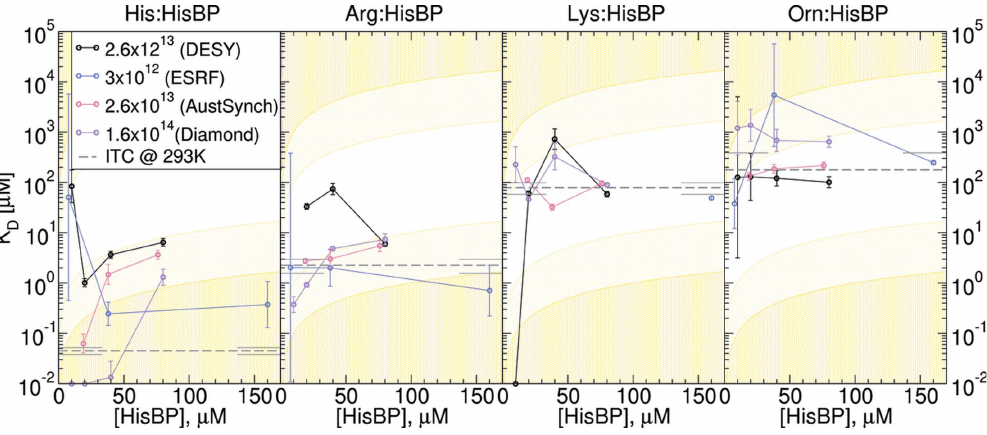
Figure 5 Computed K D from V R curves in Fig. 4, plotted as a function of receptor concentration [HisBP] and total photon dose. Colours represent replicates at different total doses: (black) 2.6 (cid:8) 10 13 photons at DESY, (blue) 3 (cid:8) 10 12 photons at ESRF, (red) 2.6 (cid:8) 10 13 photons at Australian Synchrotron and (violet) 1.6 (cid:8) 10 14 photons at Diamond. Reference values from ITC are shown as dashed grey lines with error bars at the plot edges. Low confidence limits imposed by constant-receptor titrations are represented by light-yellow regions where K D lies outside one or two orders of magnitude of [HisBP]. For comparison, equivalent plots using other metrics are shown in Figs.